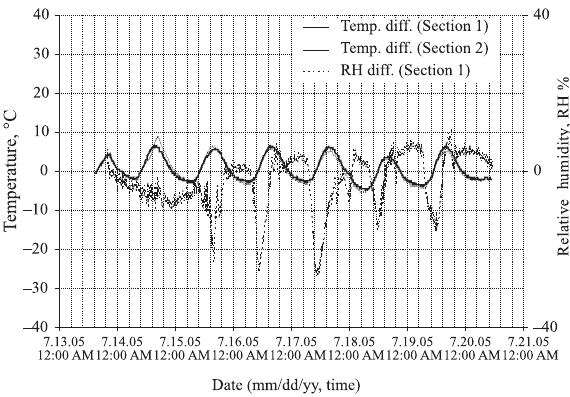
Fig. 6. Pavement temperature and moisture diff erence between the top and the bottom of slab with